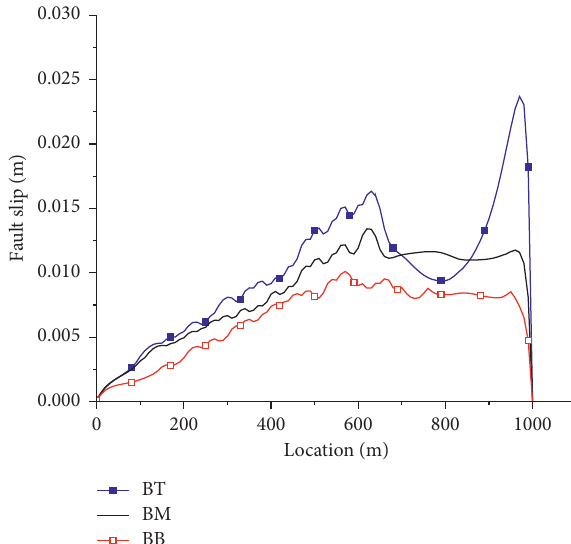
Figure 18: Fault slip along the fault plane when the fracturing region was BTR1, BMR1, or